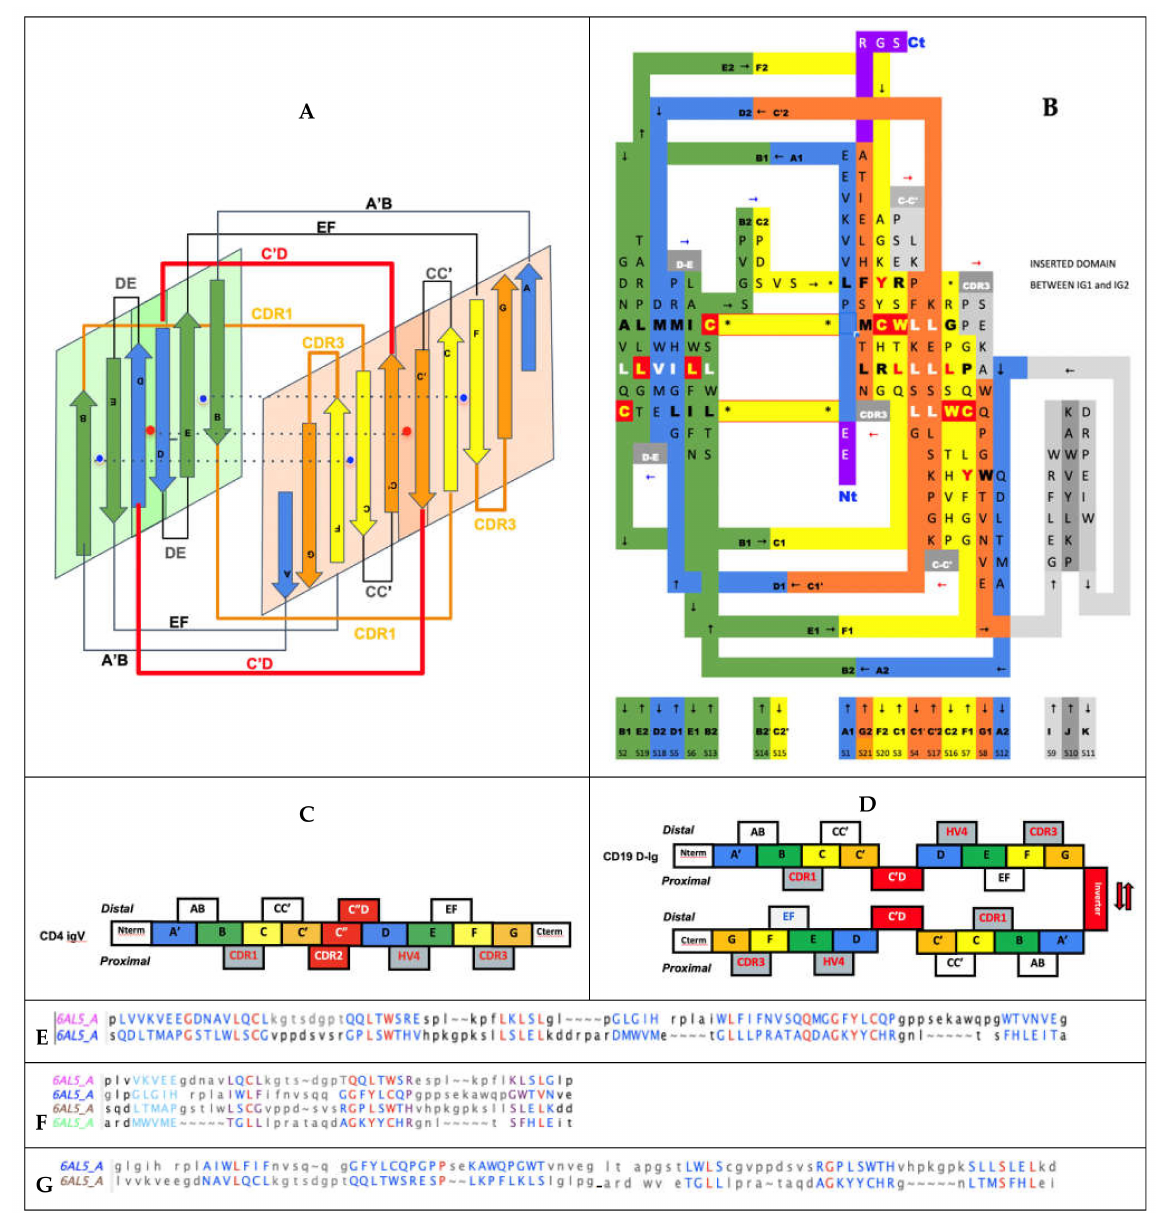
Figure 6. Double IgV domain topology (CD19). ( A ) CD19 double Ig domain topology: Topology diagram with the two sheets facing each other. The central axis of symmetry (red dot) and the two local ones (blue dots) are shown in dashed lines. ( B ) The topology/sequence map showing the pairing of individual residues in complementary beta strands. The comparison with the topology/sequence map for a single Ig domain in Figure 1D shows a conserved organization of composite Ig domains within the double domain, including the CCWL pattern (highlighted in red), as it is in a swapped dimer in Figure 5C. ( C ) Sequence of an IgV with an A’ and no A strand as in CD4, marking the sequence stretches for strands and loops. The (CDR2-C”-C”D loop) linker inverts protodomain 2 A’GFCC’ vs protodomain 1 BED. The CDR loops CDR1, CDR2, and CDR3 and HV4 are all on the same side, here defined as proximal for comparison. ( D ) The CD19 sequence composed of protodomain 1 AB-CC’ and protodomain 2 DE-FG in parallel with a C’D short linker. In the first, a sequential parallel Ig domain CDR1 on the proximal side vs. CDR3 and HV4 on the distal side. The second duplicated parallel Ig domain composed of protodomain 3 and 4 is inverted through a small, inserted domain (in grey in ( B )). This positions the two parallel Igs to intercalate and form a double Ig domain formed by two long sheets: (BED)1(DEB)2 vs. (A’|GFCC’)1(C’CFG|A’)2. In doing so, two fused composite Ig domains are formed combining p1 + p4 as an Ig domain of topology (AB-CC’|DE-FG) and p2 + p3 as an inverted Ig domain with the topology (DE-FG|AB-CC’), since, in sequence, p2 (DE-FG) precedes p3 (AB-CC). The variable regions (CDR1, CDR3, and HV4) for the first composite Ig domain (p1 +